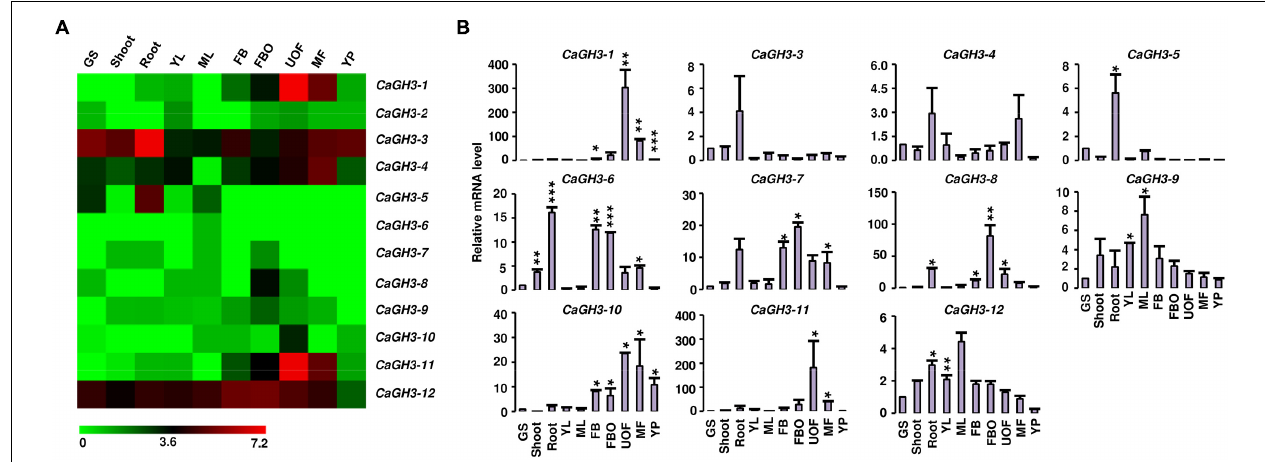
mRNA level in other tissues for each gene. Error bars indicate SE of mean. YL , young leaf; ML, mature leaf; FB, flower bud; UOF, unopened flower; FBO, flower bud open; MF, mature flower; YP, young pod. Data points marked with asterisk (* P ≤ 0.05, ** P ≤ 0.01, and *** P ≤ 0.001) indicate statistically significant difference between control (GS) and other